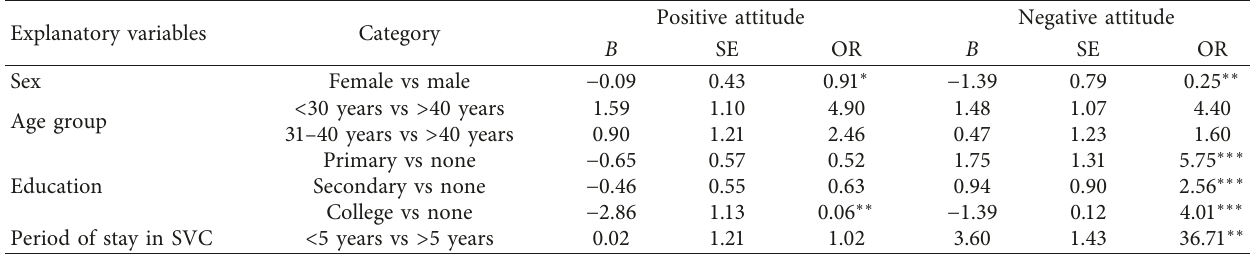
Table 3: Parameter estimates of variables in the multinominal logistic regression (MLR) model used to predict local people’s attitudes toward wildlife species conservation in Save Valley Conservancy. Parameters for “negative attitude” ( n � 114) and “positive attitude” ( n � 78) are presented while parameters for the “neutral attitude” ( n � 98) were taken to be the reference category for each of the scenarios. Explanatory